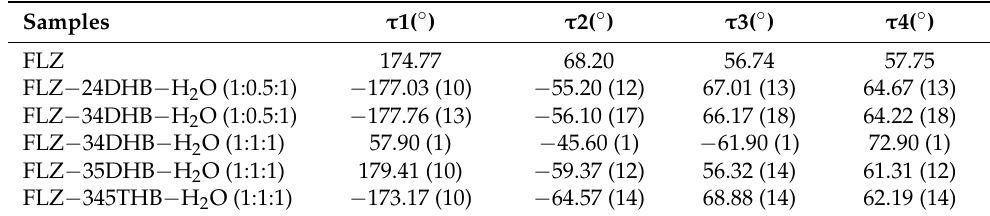
Table 2. Torsion angles of FLZ and its cocrystal